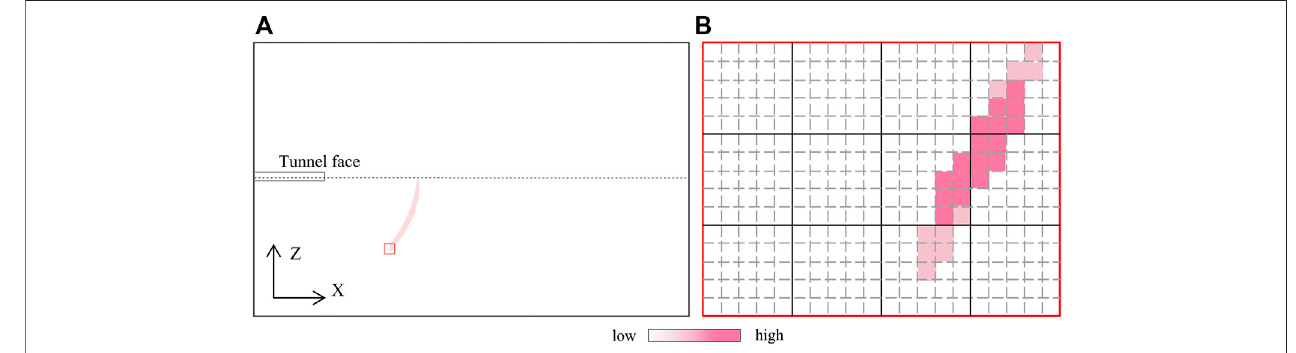
FIGURE 2 | Principle diagram of re fl ection energy arc of migration. (B) is the partially enlarged schematic diagram of the marked out by the red rectangle in (A) .